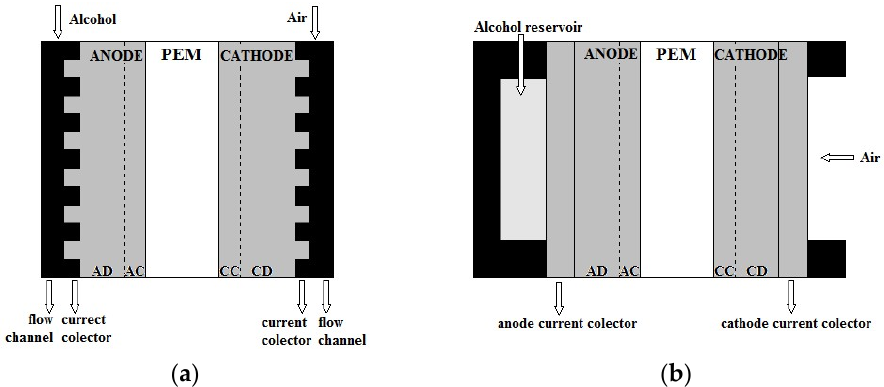
Figure 2. General main operating modes of DAFCs: ( a ) active and ( b ) passive. Reproduced from [16] with permission from 2018 Elsevier.